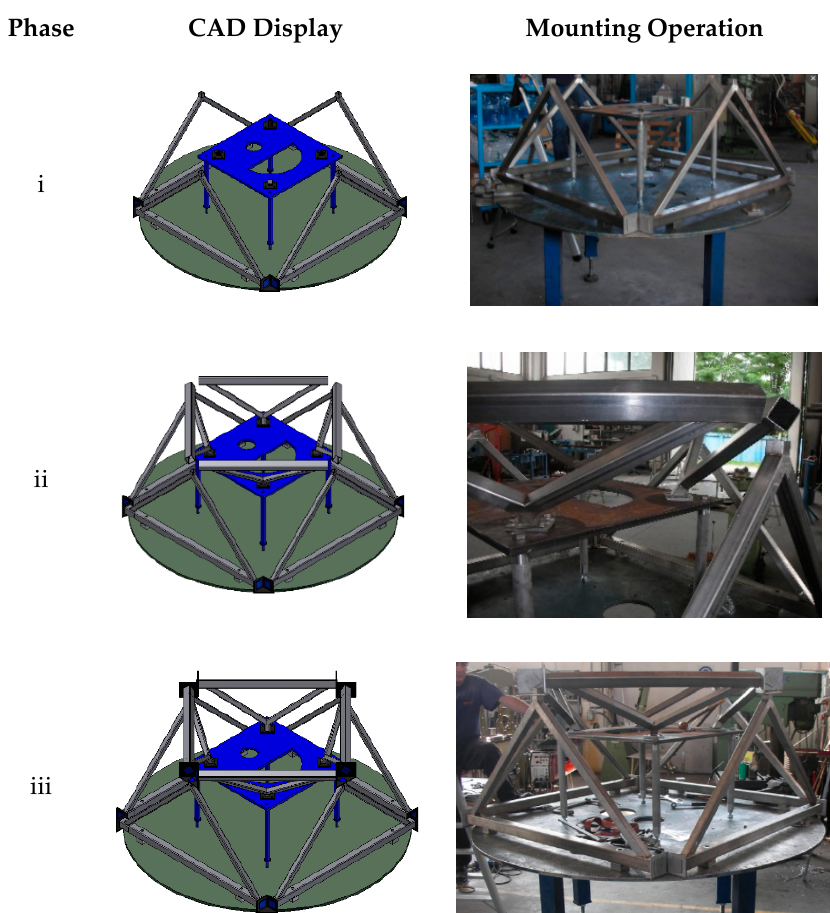
Figure 3. Steps of the assembly of the [21] base: (i) joining of larger modules; (ii) mounting of the smaller modules onto the reference (in blue); (iii) joining of larger and smaller modules.